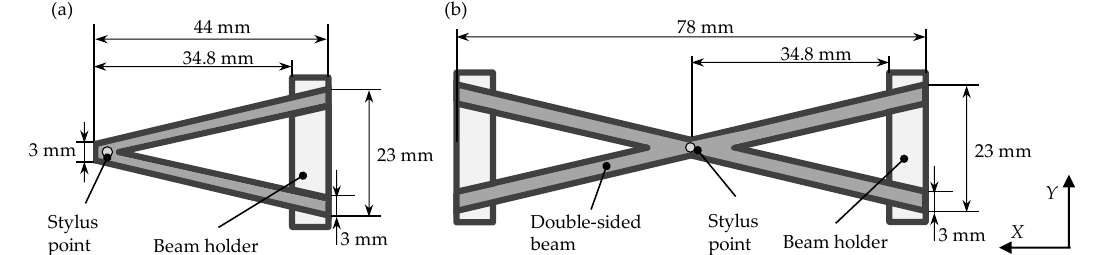
Figure 3. Schematic of the flexible beam: ( a ) cantilever beam; ( b ) double-sided beam. Moreover, to avoid the slip of the stylus tip in the measurement process, the lateral force to be applied to the stylus should be less than the maximum static friction force.